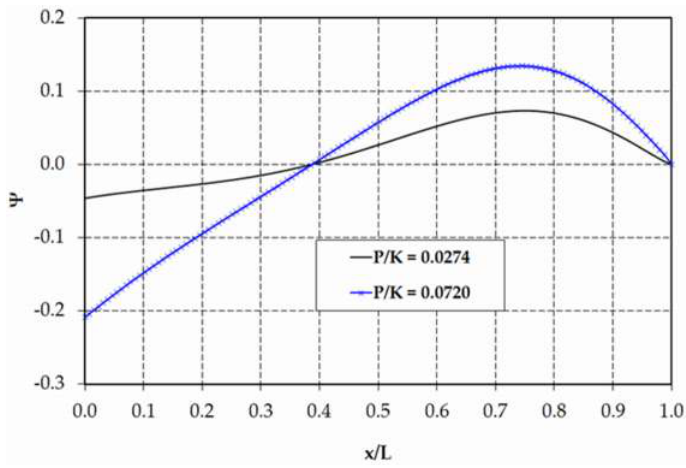
Figure 9. Variation of the relative curvature of the bedrock profile in the streamwise direction.